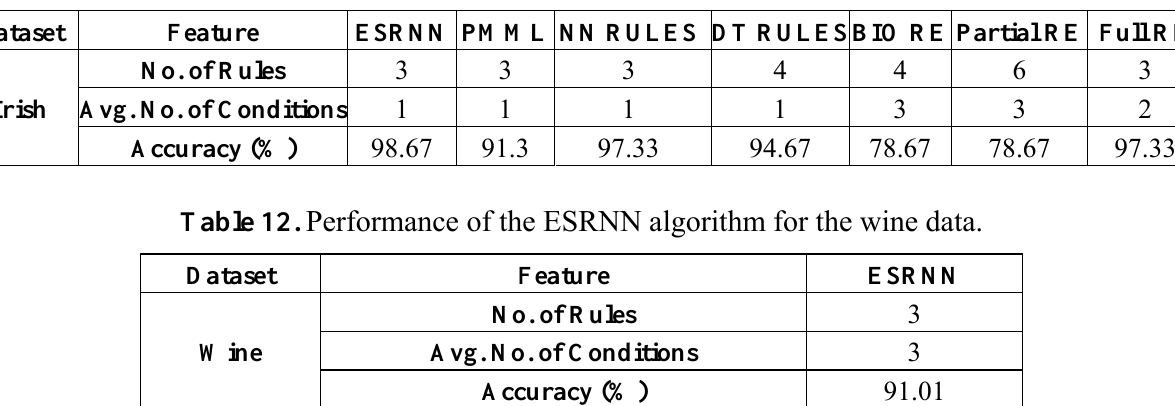
Table 11. Performance comparison of the ESRNN algorithm with other algorithms for the irish data.